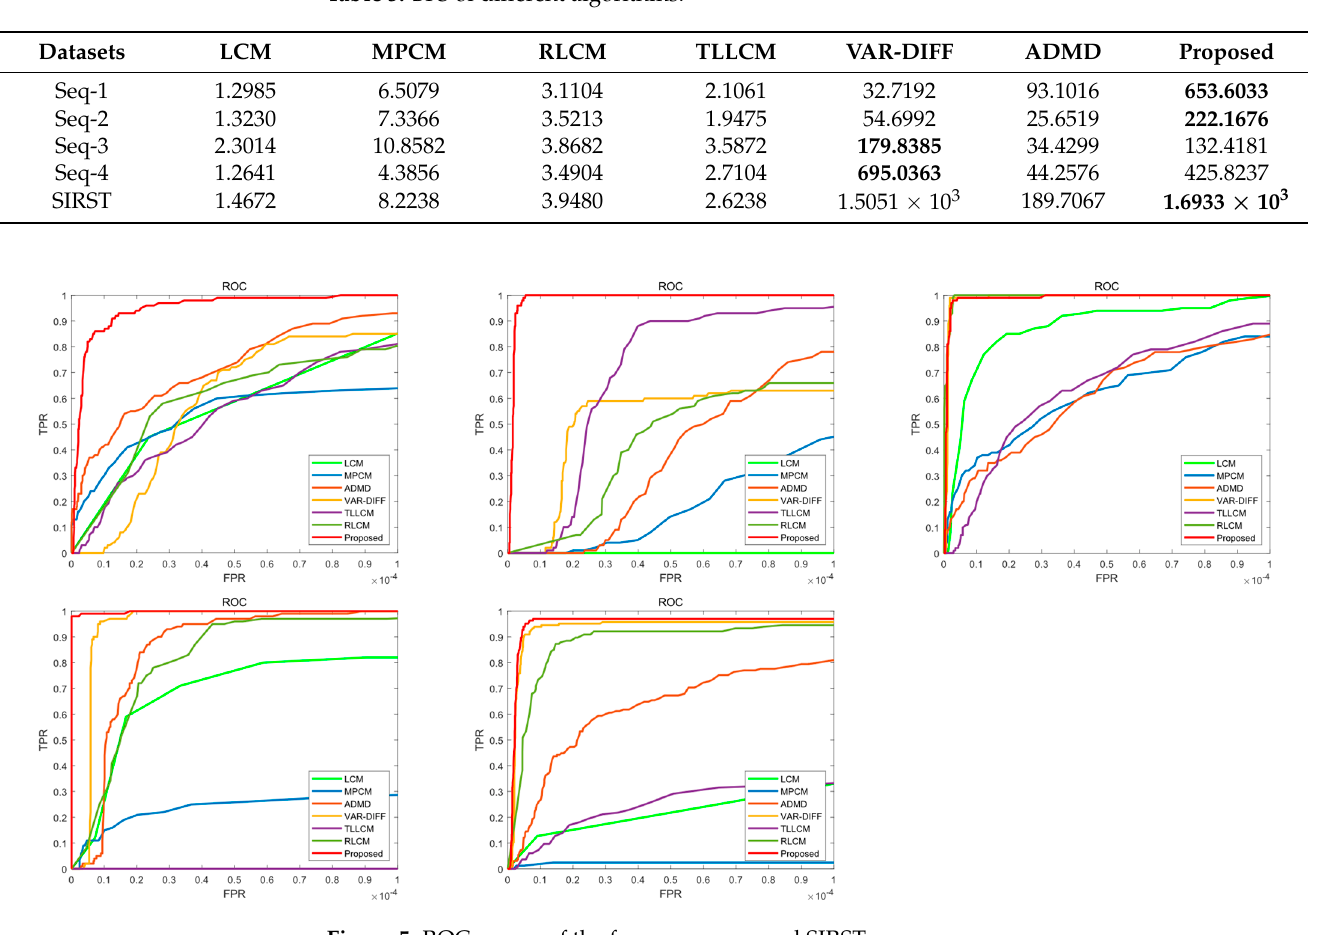
Table 3. BFS of different algorithms.